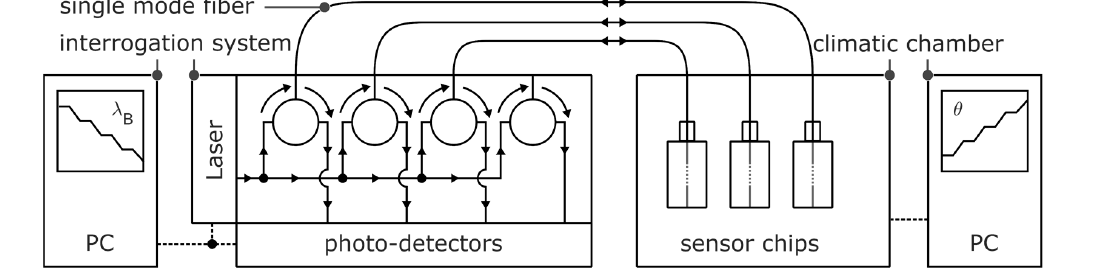
Figure 2. Schematic illustration of the experimental setup.